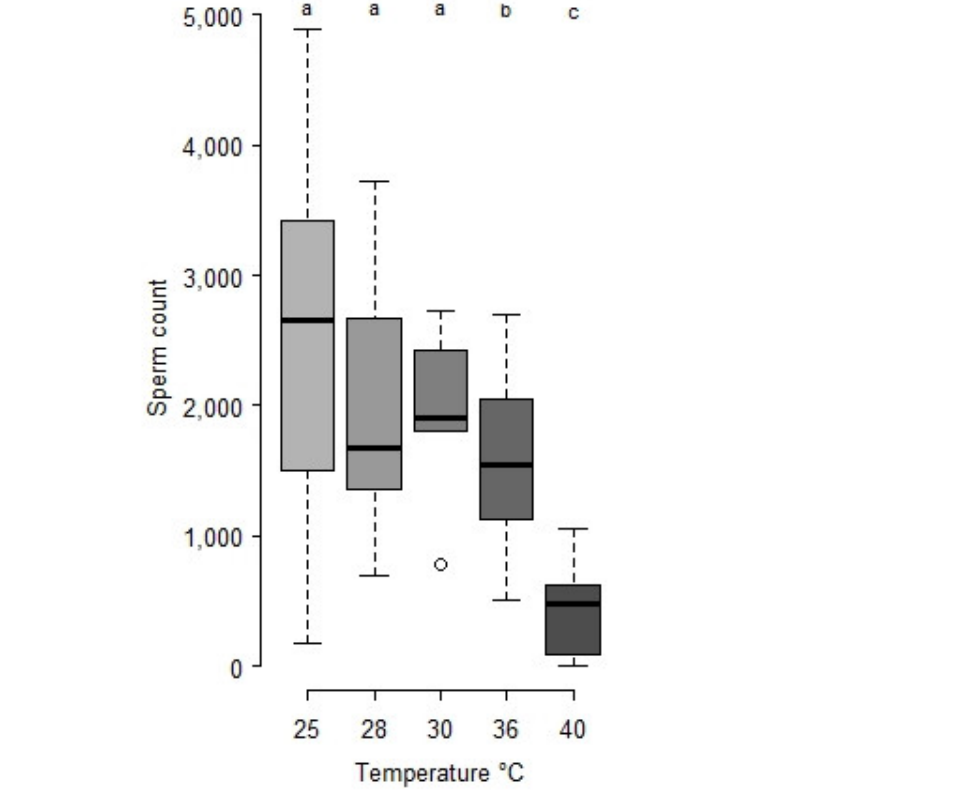
(log-rank test, Chi²= 59.4, df = 2, p < 0.001). The mid survival (50%) is reached after 28 days at 40 °C.